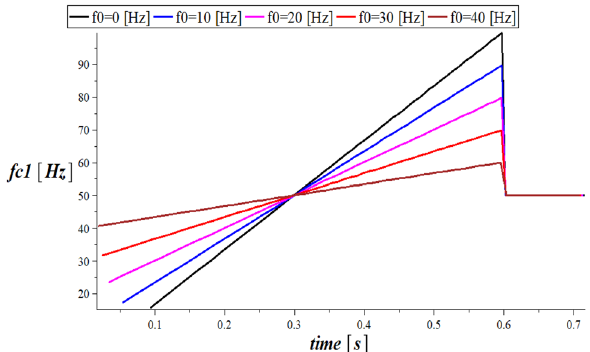
Fig. 7 Frequency of the voltage (the dotted line, f 0 = 0 (Hz) ) and dynamic frequency of current f c ( t ) for sinusoidal increase of volt-